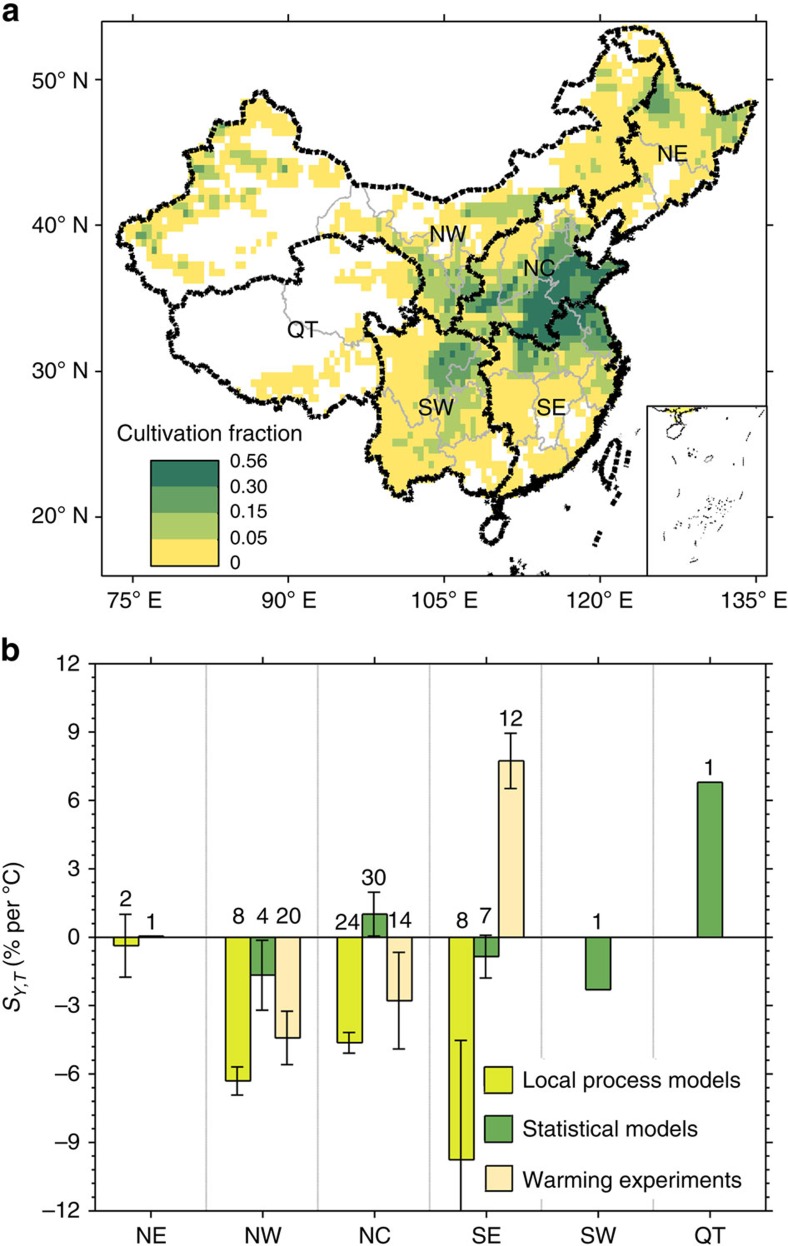
Spatial patterns of wheat cultivation fraction and SY,T in China.(a) Wheat cultivation fraction of six production zones in China. NE, NW, NC, SE, SW, QT represent Northeast China, Northwest China, North China, Southeast China, Southwest China and Qinghai-Tibet, respectively. (b) Regional differences of SY,T for different approaches (mean±s.e.m.). The number of observations used in the analysis is shown above each bar. Map was created using Matlab R2014b.